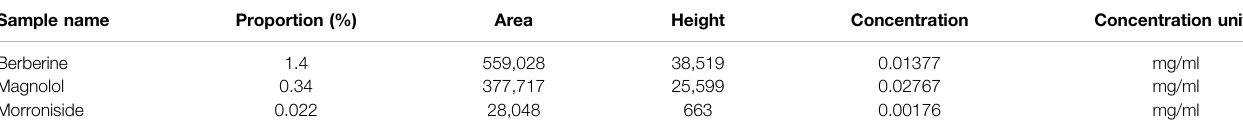
TABLE 2 | HPLC analysis of SHTXF representative components.